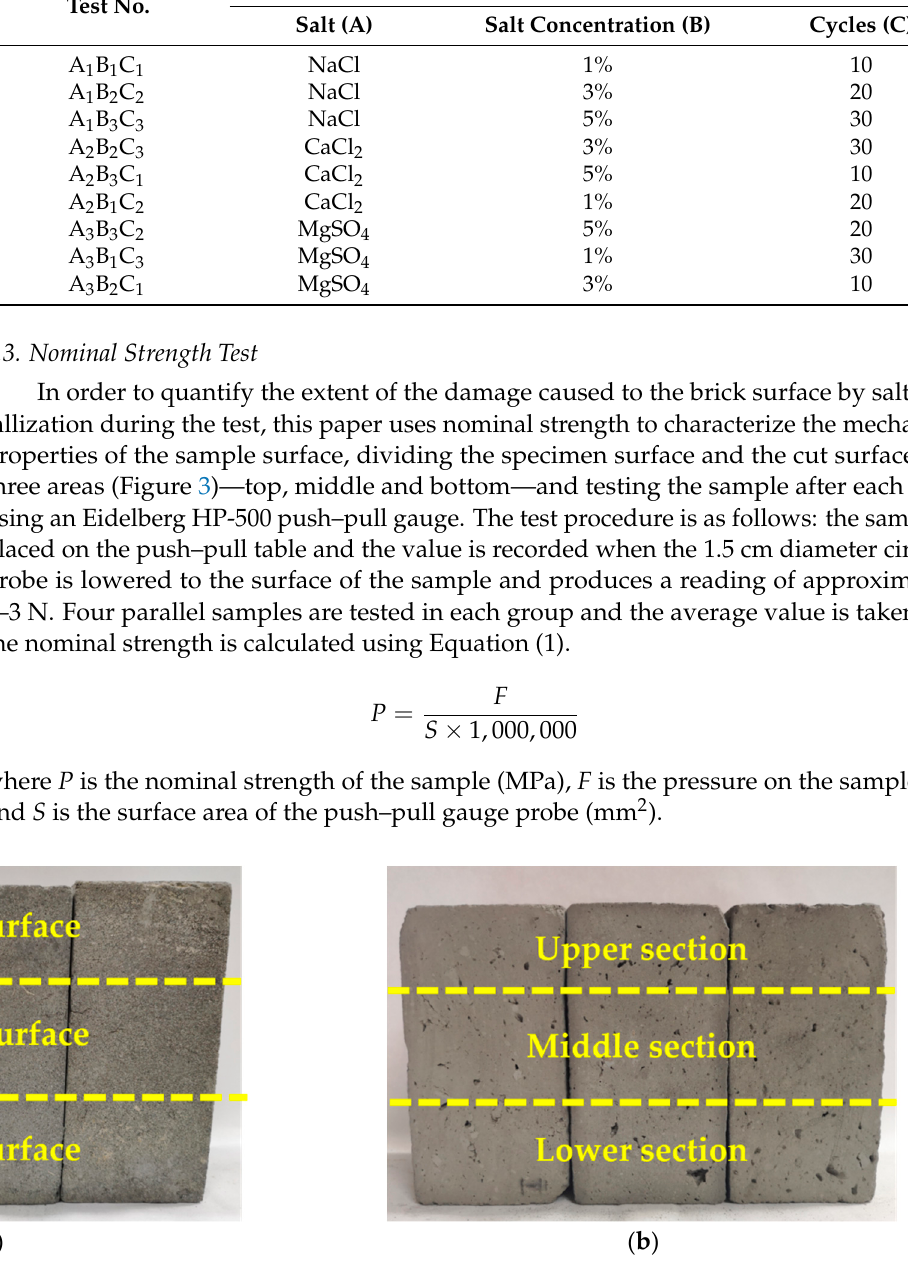
Figure 3. Diagram of the different test areas for the nominal strength of the sample: ( a ) the surface of the sample; ( b ) the cutting surface of the sample.